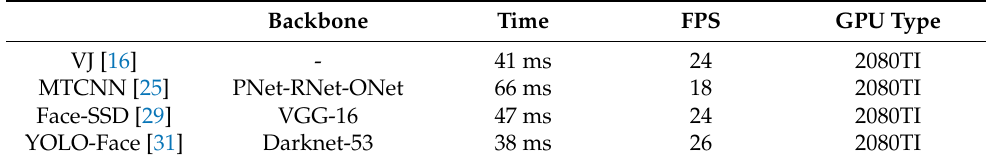
Table 5. Time comparison between different face detection methods for VGA images on NVIDIA GTX 2080-TI GPU.